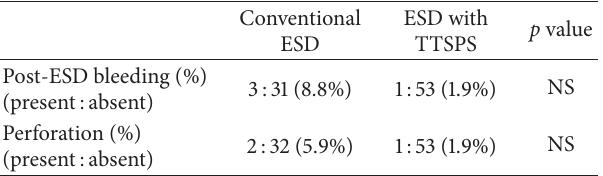
Table 4: Comparisons of complications between conventional ESD and ESD with